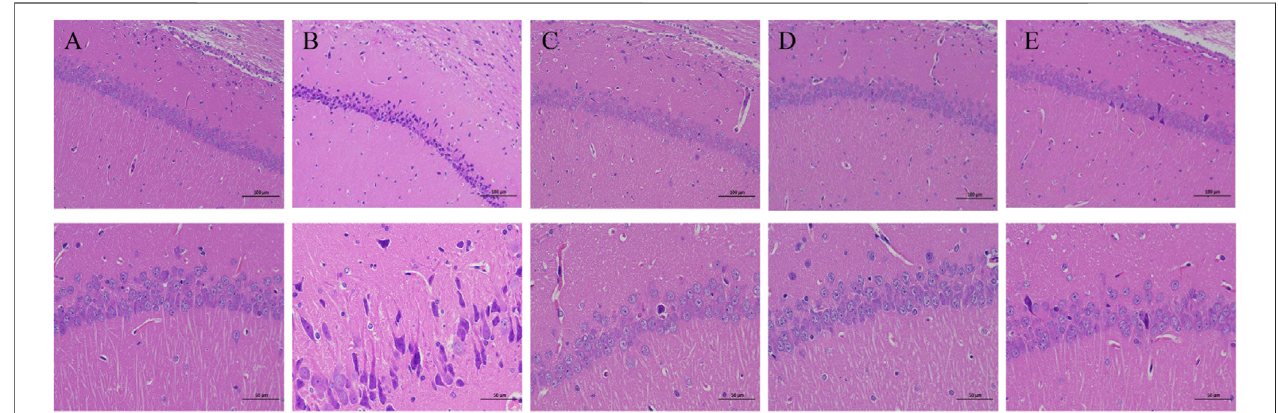
FIGURE 2 | Cattle bile Arisaema (CBA) relieved the hippocampal neuronal injury by HE staining (200× and 400×). (A) control; (B) FS model; (C) FS + sodium valproate; (D) FS + CBA-H; (E) FS + PBA-H.